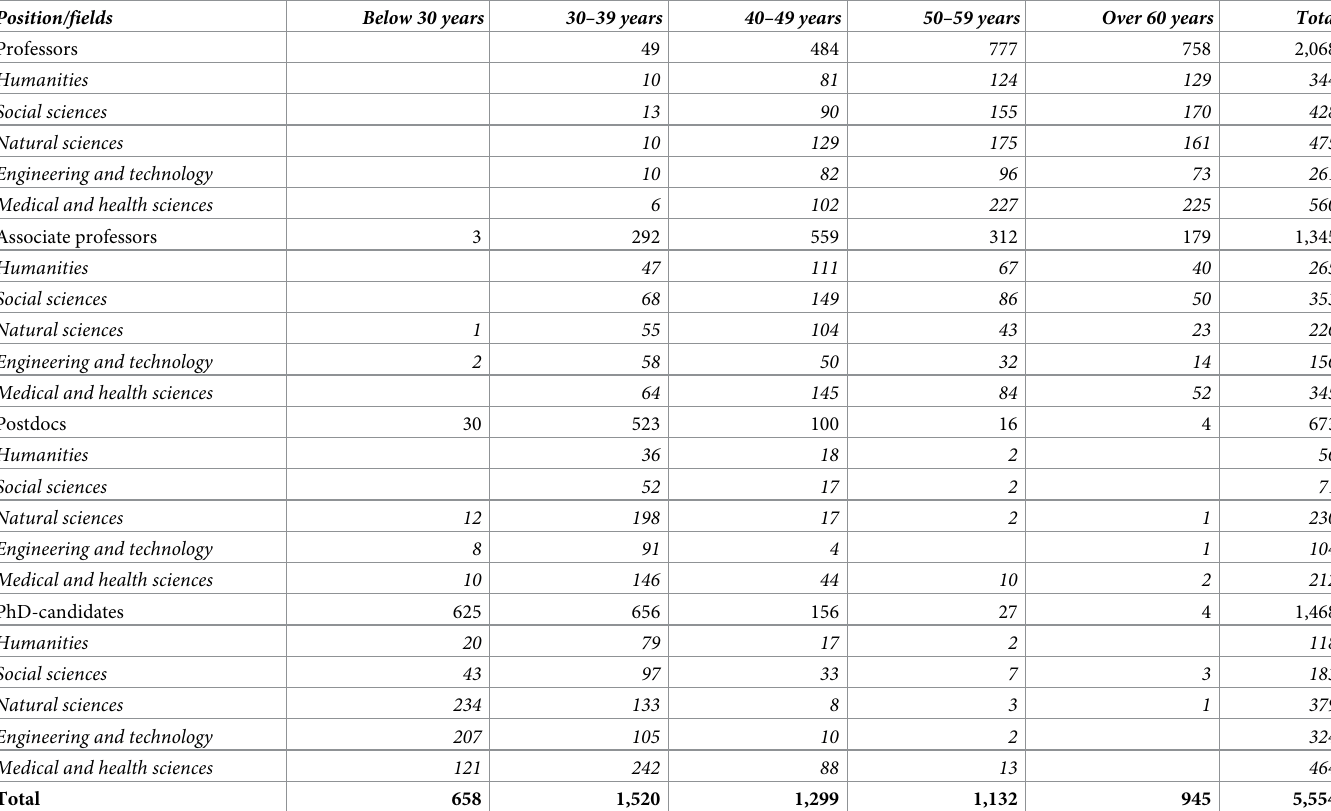
Table 1. Distribution of number of researchers by major fields, position and age groups (N = 5,554).